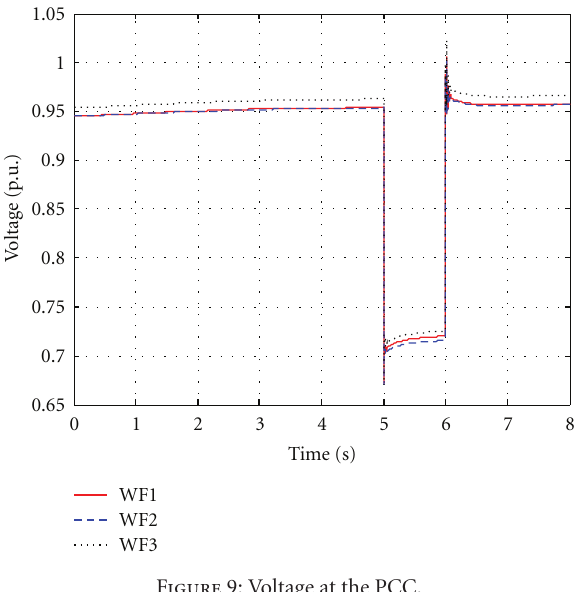
Figure 9: Voltage at the PCC.